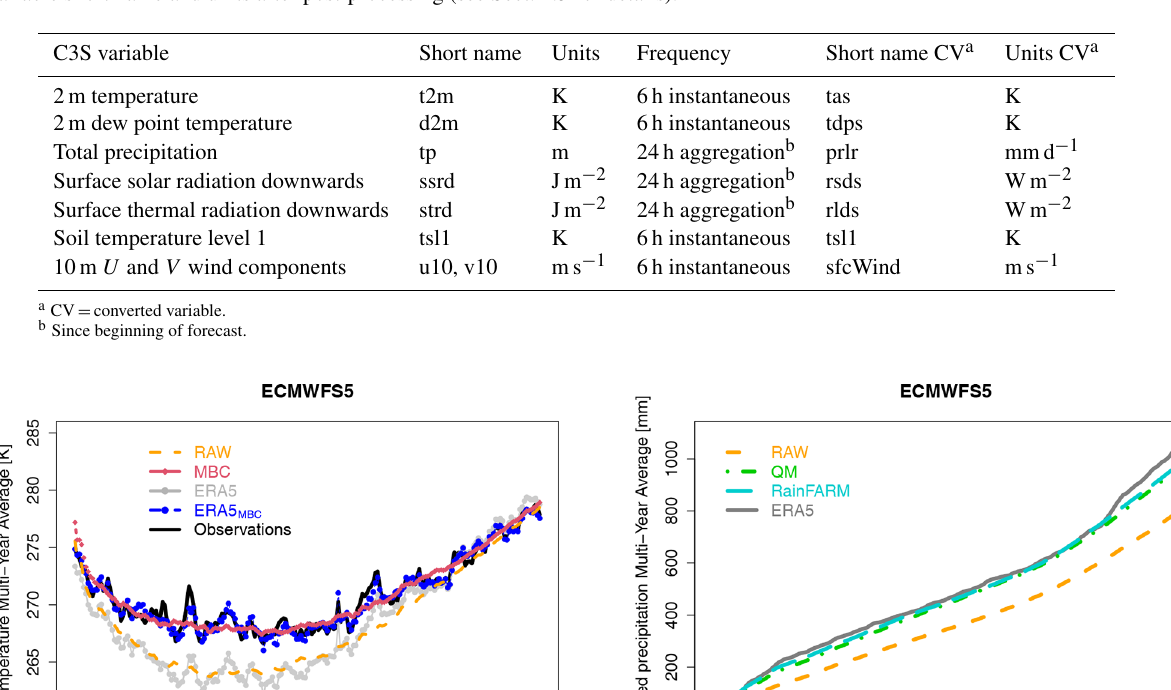
Table 2. C3S seasonal forecast model variables used to create the forcing for the prototype: original variable name, short name and units, and variable short name and units after post-processing (see Sect. 2.3 for details).